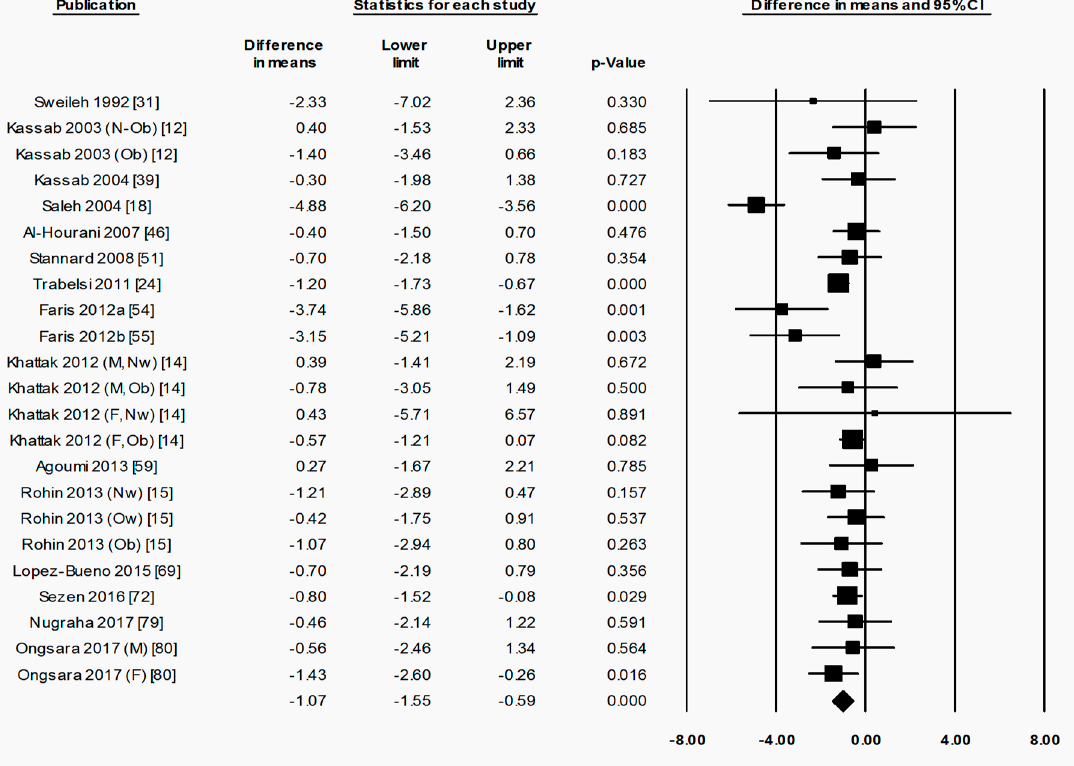
Figure 2. Fat percentage was significantly decreased by Ramadan fasting. Change in fat percentage (%) between pre-Ramadan (pre-R) and the end of Ramadan (post-R). Heterogeneity statistics: T = 0.829, p < 0.001, I 2 = 61.5%. F = female; M = male; Nw = normal weight; Ow = overweight; Ob = obese; N-Ob = non-obese.